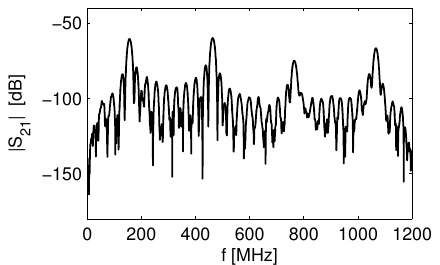
Figure 4. Transfer function S 21 of a delay line with four harmonics (after signal